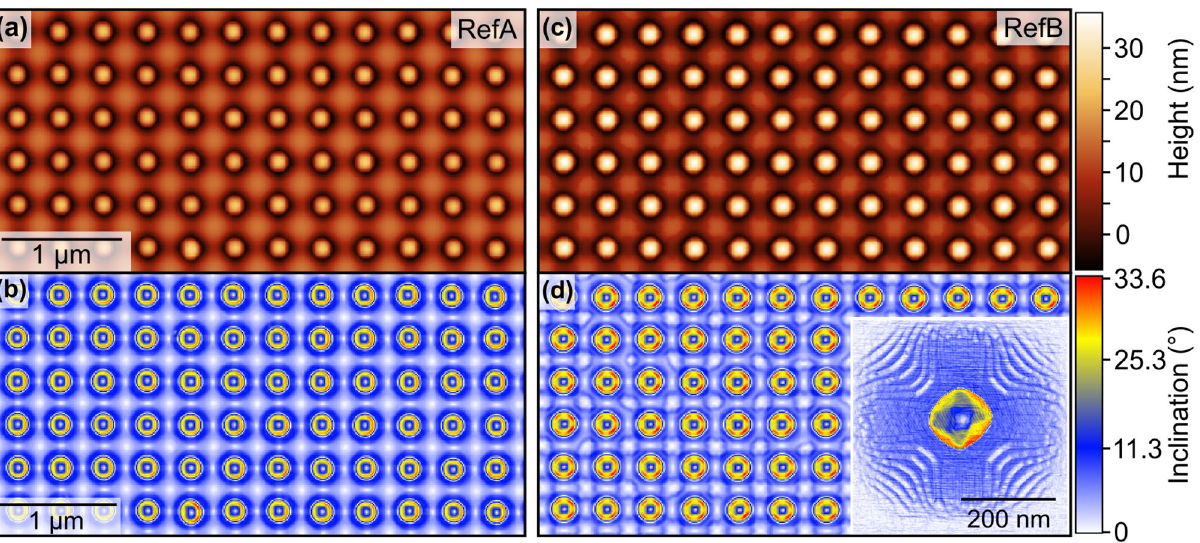
Figure 1. ( a , b ) AFM micrographs of the un-capped samples RefA (left) and RefB (right), respectively, from the pre-patterned areas with a pit period of 340nm. The inclination maps ( c ) and ( d ) show the characteristic facets of dome-shaped dots, i.e., {15 3 23} indicated in red, {1 1 3} shown in yellow and the shallow top with a {1 0 5} facet (blue). Inset: Enlarged image of one pit with its dome-shaped QD showing the facets in higher magnification as well as the decoration of the pit sidewalls with {1 0 5}-facetted ripples (blue) and (001) terraces